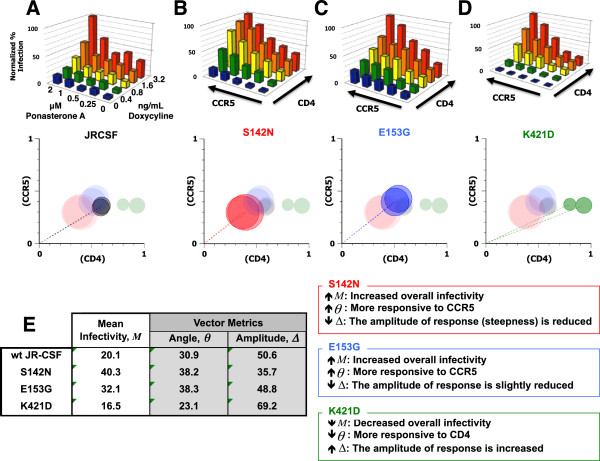
Sensitivity vector metrics further illuminate the phenotype of well-characterized point mutants. (A) Infectivity profile of wt JR-CSF (R5) envelope, and three point mutants: (B) S142N, (C) E153G and (D) K421D, previously shown to enhance or perturb CCR5 or CD4 usage with polar plots (beneath) representing the metrics obtained from mathematical analysis of the infectivity profiles (A-C). The vector angle (θ) is the angle between the x-axis and the dotted line. The vector amplitude (Δ) is represented by the length of the dotted line. The mean infectivity (M) is represented by the size of the circle. Data shown is a representative of two experiments. (E) Table of the average Affinofile metrics obtained from (A-D) and graphically shown in polar plots beneath (A-D). Boxes next to (E) describe the phenotypes indicated by each metric relative to wt JR-CSF. The infectivity profile of each Env was independently repeated twice.